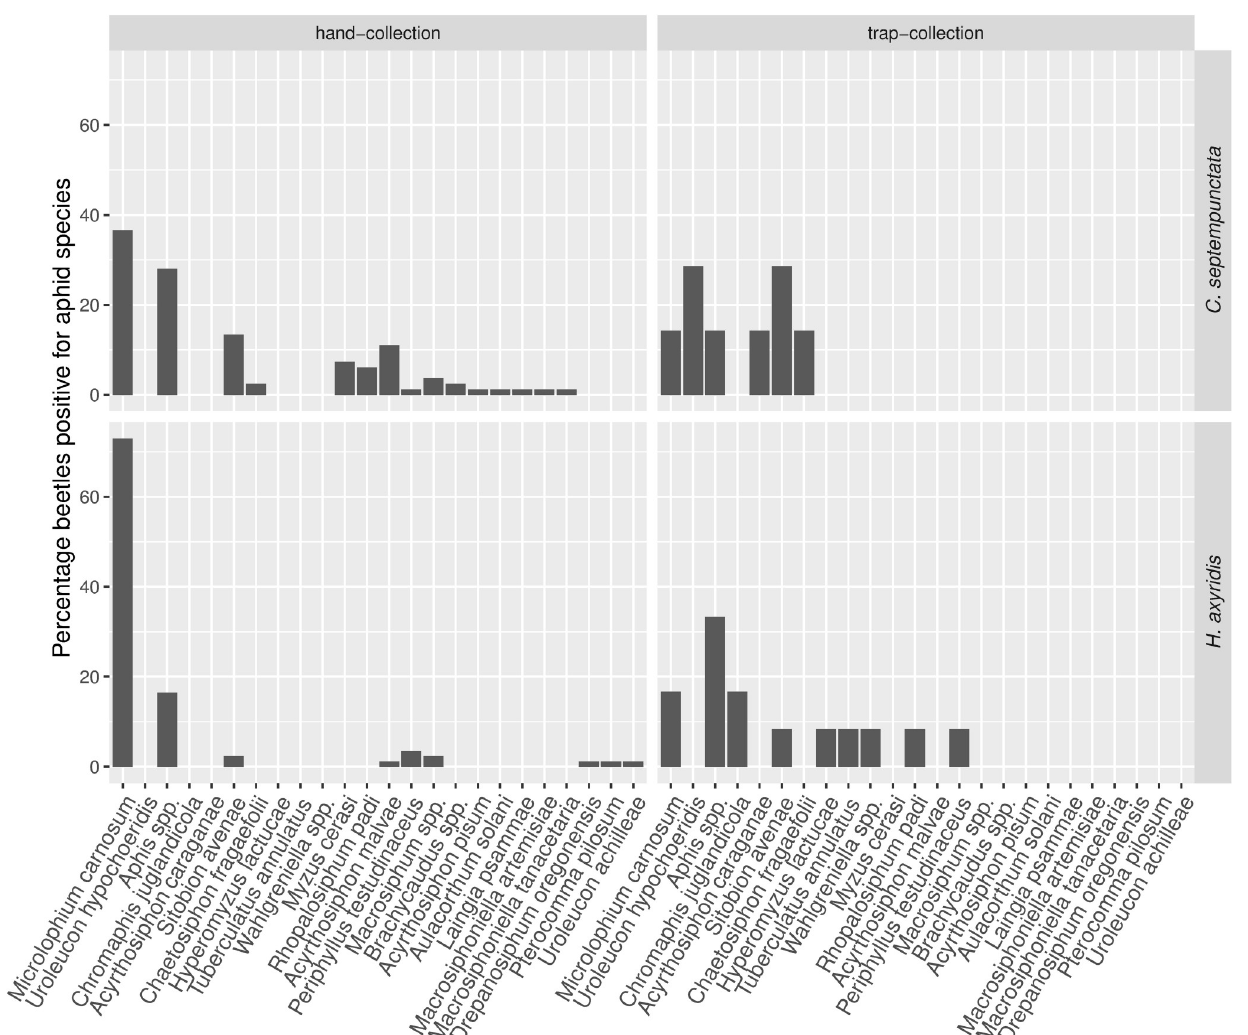
Fig 4. Aphid prey species consumed by the two studied ladybird species. Total number of hand-sampled ladybirds positively tested for aphids was 167 compared to 19 trap-sampled ladybirds (see S1 Data for more detail).